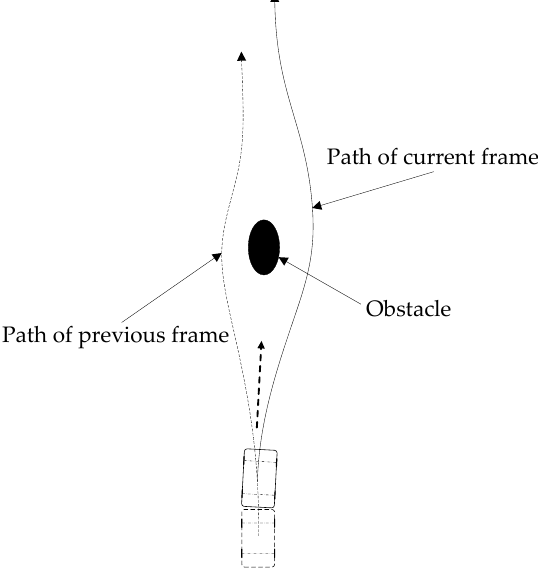
Figure 3. Path difference between current and previous frames.